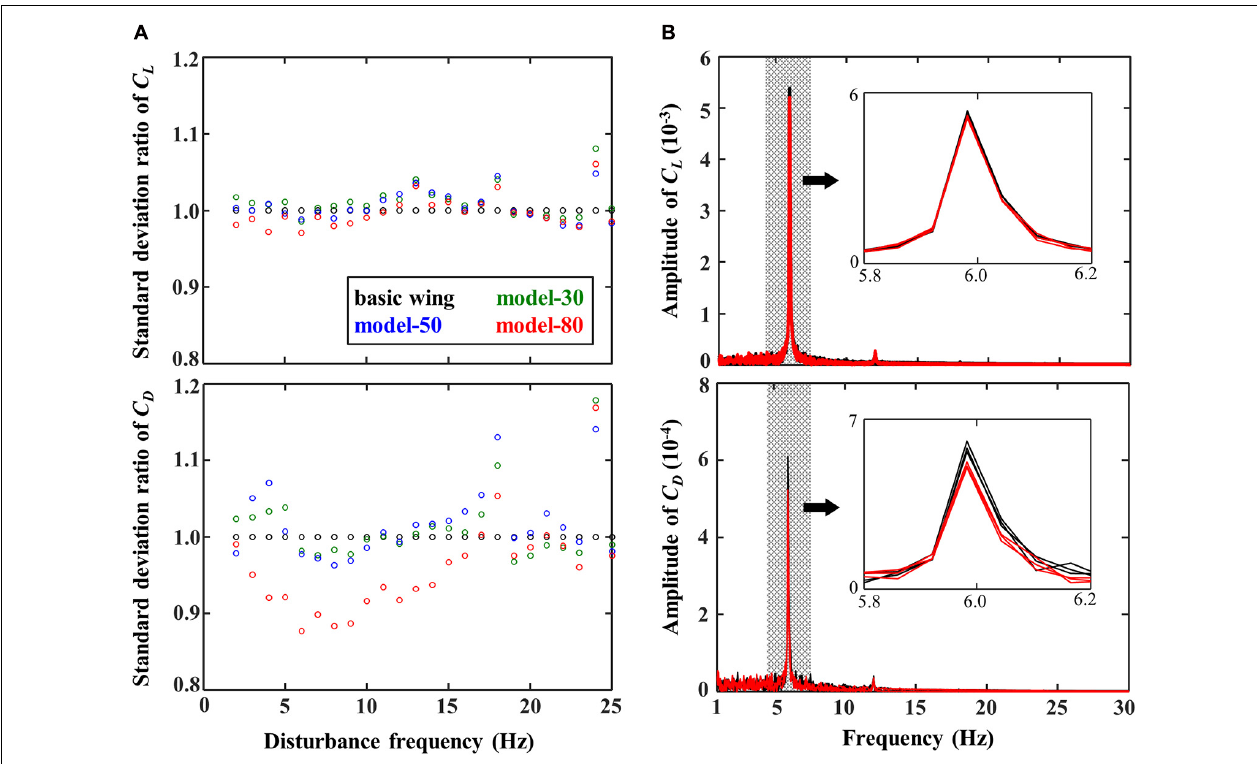
FIGURE 5 | (A) Effect of the disturbance frequencies on the standard deviation ratio of C L and C D relative to the basic wing at an angle of incidence of 5 degrees. (B) Frequency spectra of C L and C D at disturbance frequency of 6